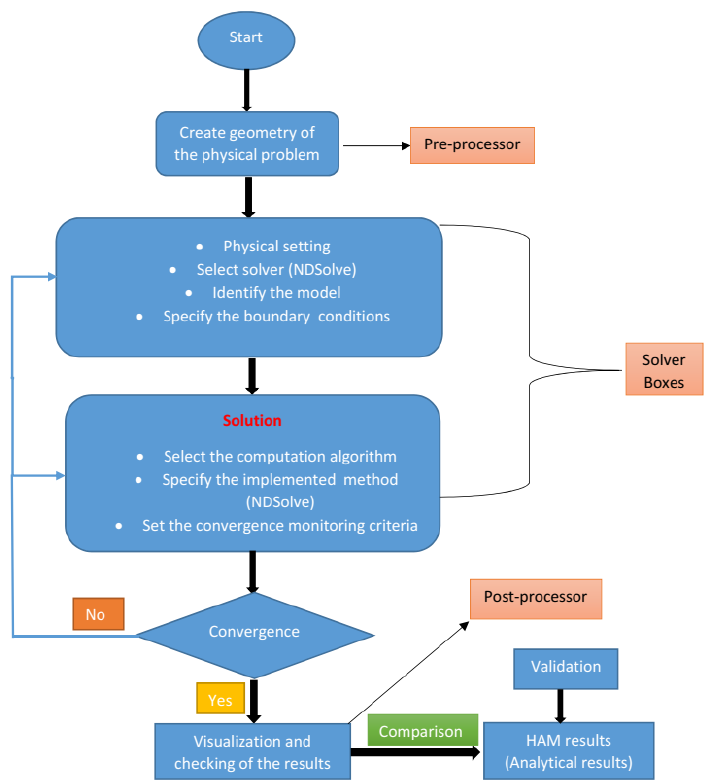
Figure 2. Solution methodology schematic diagram.